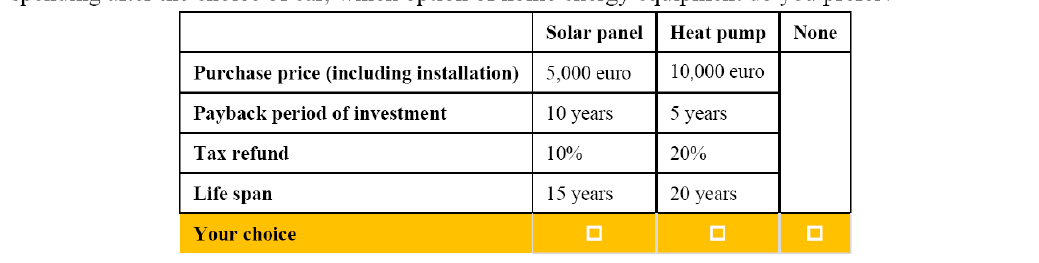
Figure 2. An example of the choice experiment of home renewable energy equipment.